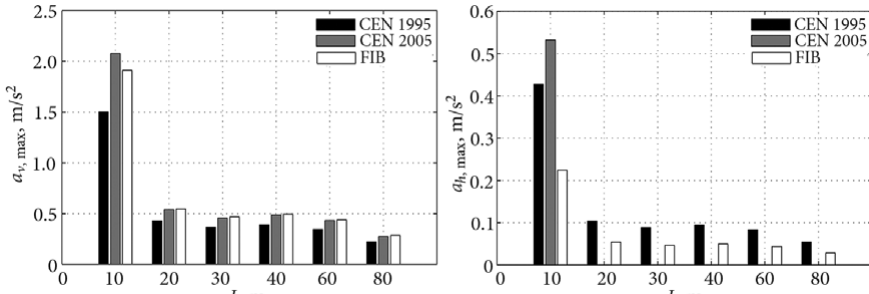
Fig. 12. Vertical and lateral accelerations induced by a group of walkers